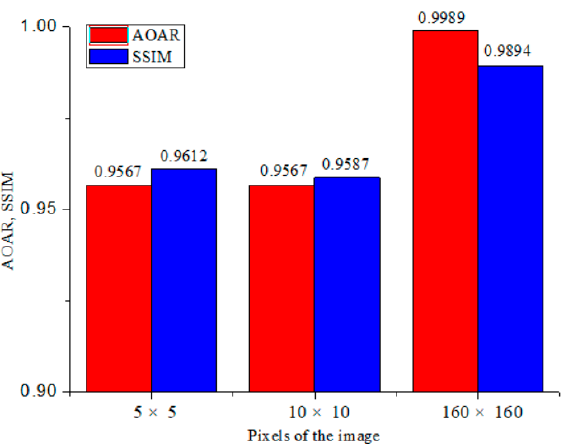
Figure 13. ( a ) The depth image of the target with 160 × 160 pixels. ( b ) Front view of ( a ).